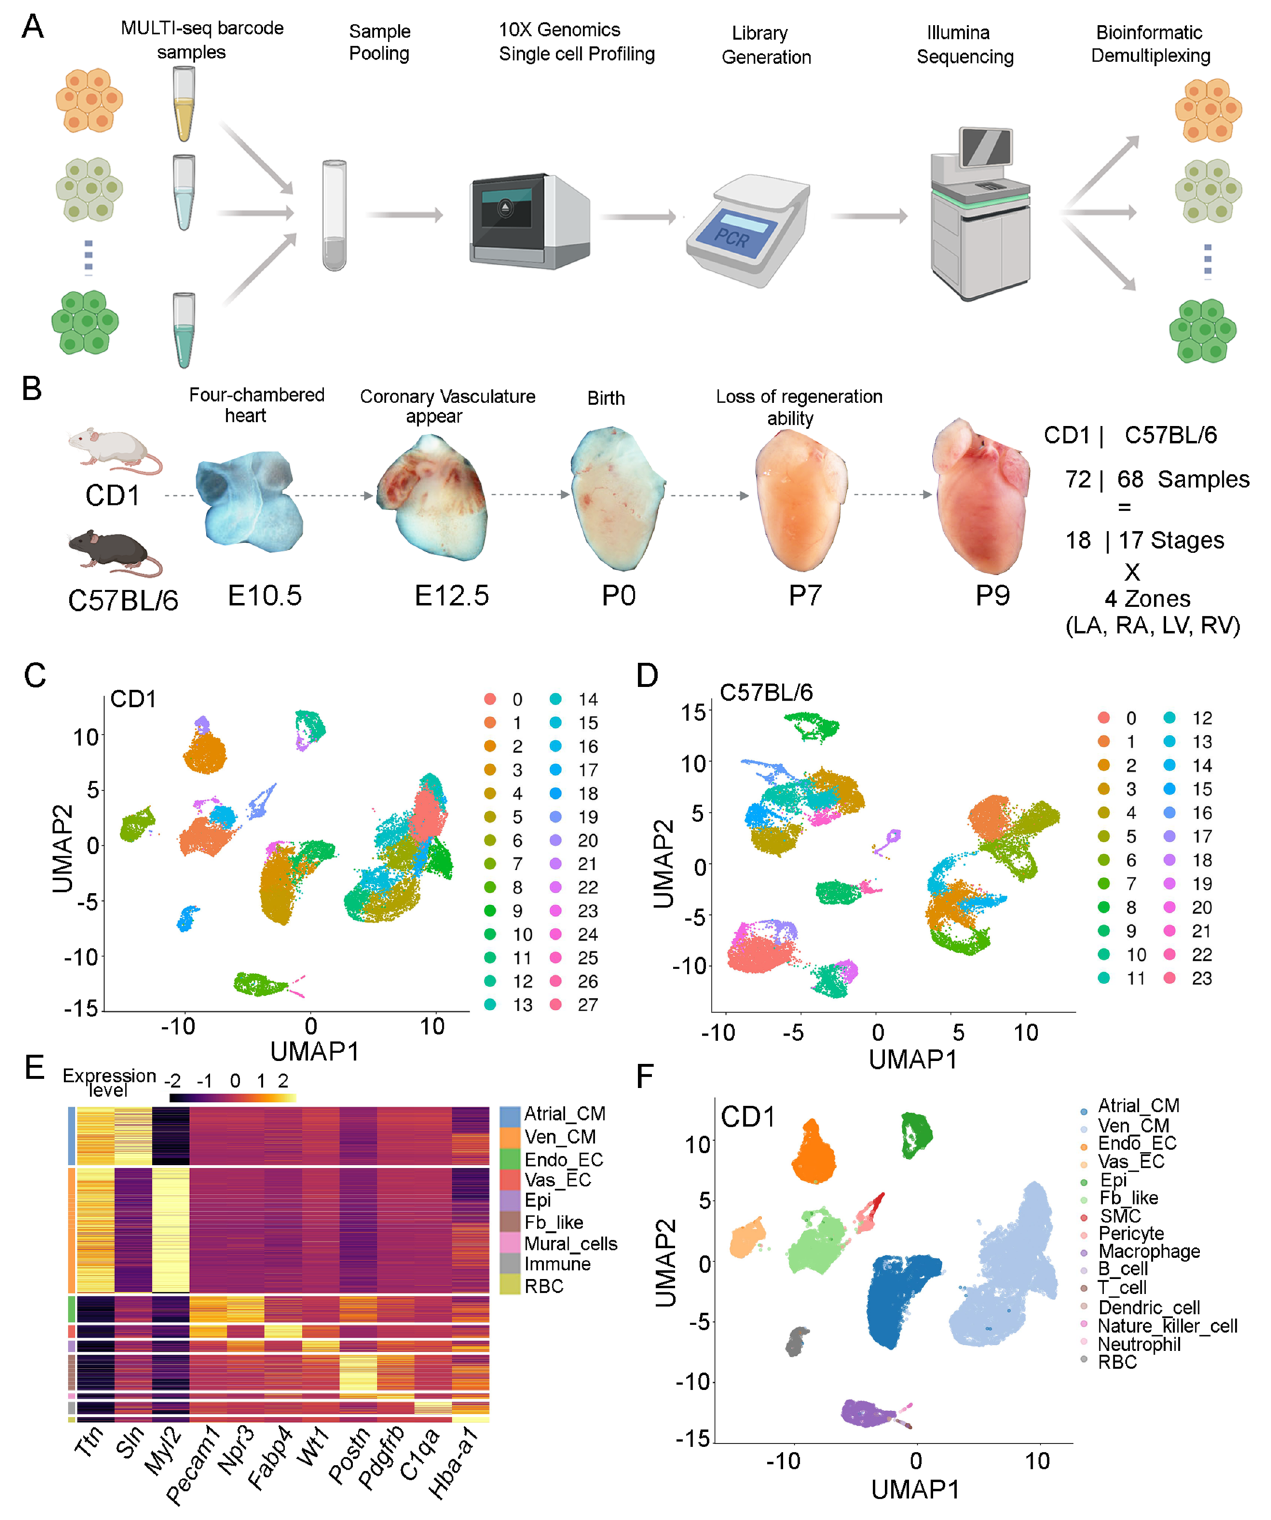
Fig.1|ScRNA-seqanalysisofthedevelopingheartsatembryonicandneonatal stages. A Diagram of the MULTI-seq procedure. Each sample was stained with a unique MULTI-seqbarcodebeforepooling and loadinginto the 10× Chromiumfor single cell capturing. The captured single cells were converted into libraries for sequencing and demultiplexing for downstream bioinformatic analyses. B Our